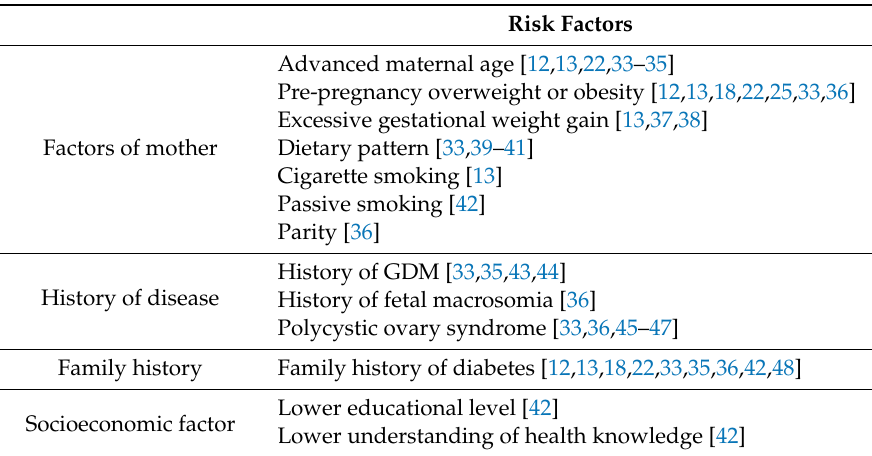
Table 3. Risk factors for